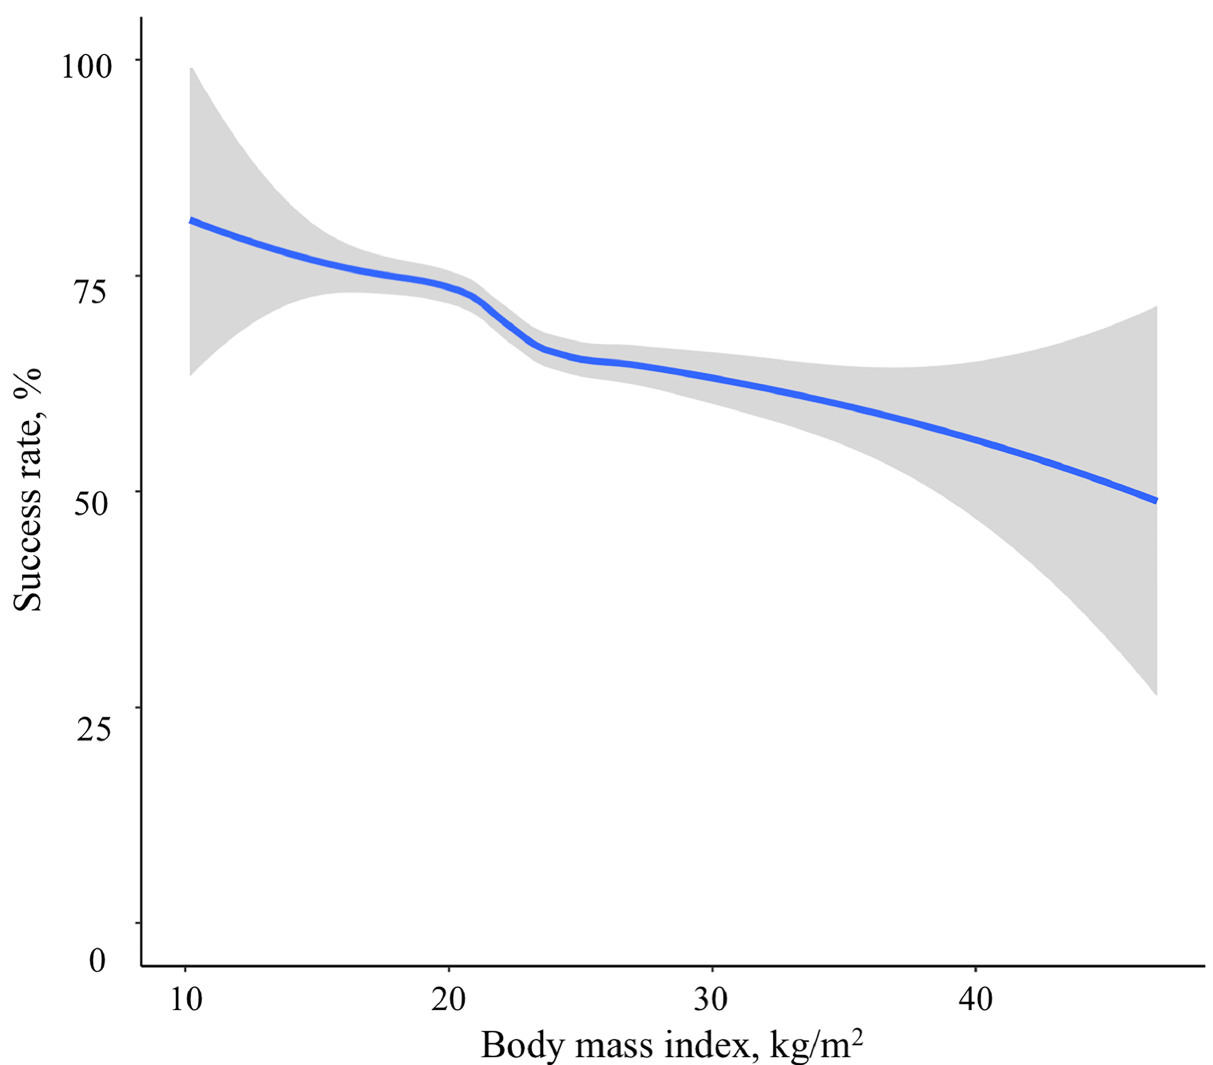
Fig 1. Association of body mass index with the success rate on the first intubation attempt. The fitted line represents locally weighted scatterplot smoothed (LOWESS) curve. There was a negative relationship between body mass index and success rate on the first intubation attempt.